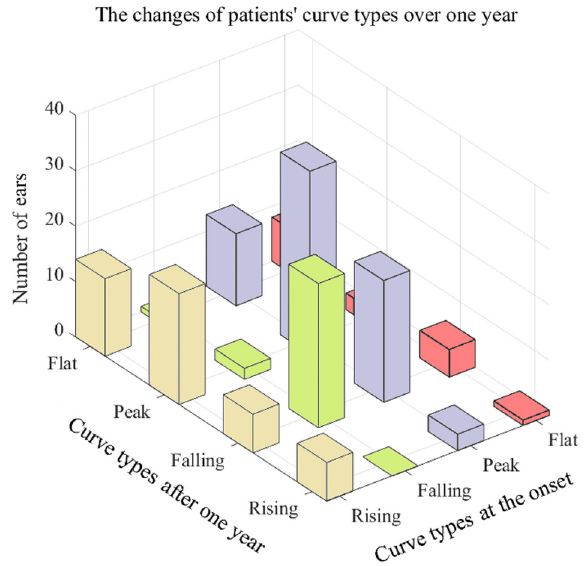
Figure 5. Changes in patients’ curve types over one year.